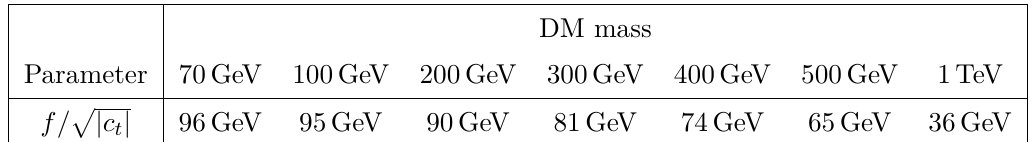
Table 4 . As table 3 but for the j + E miss